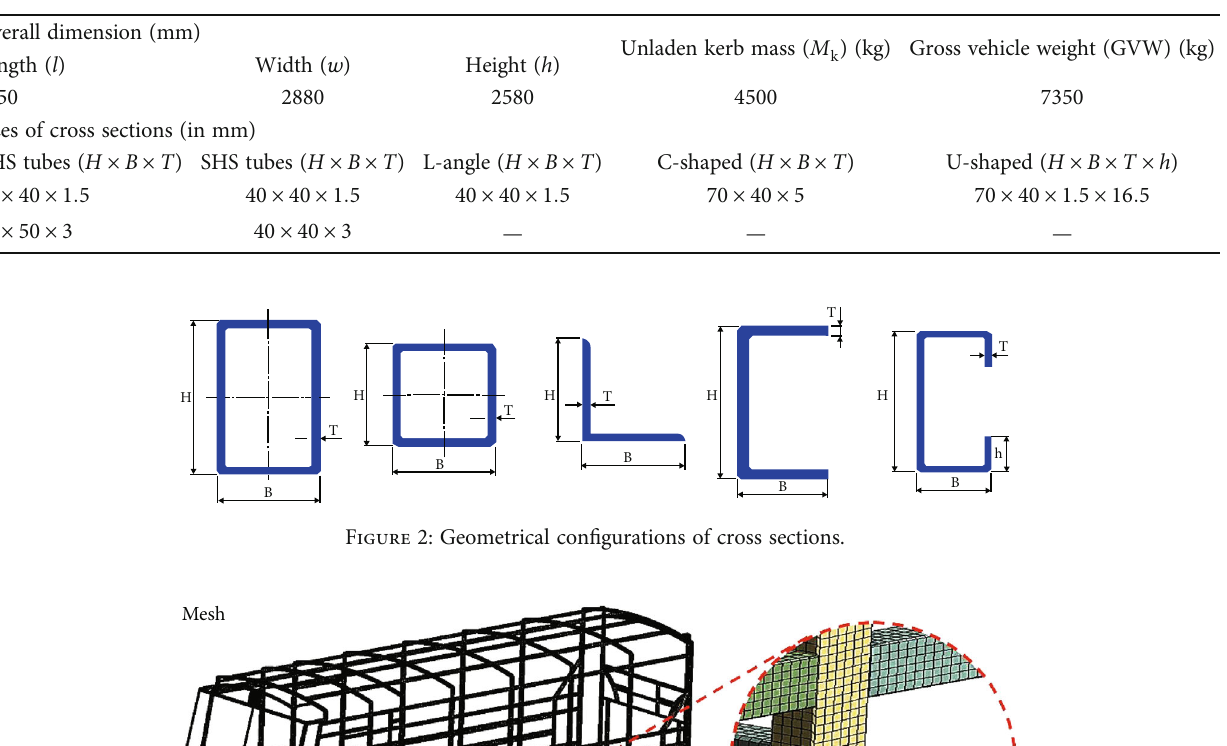
Table 1: General speci fi cation of the midibus (NPR 71K chassis) with the size of cross sections.